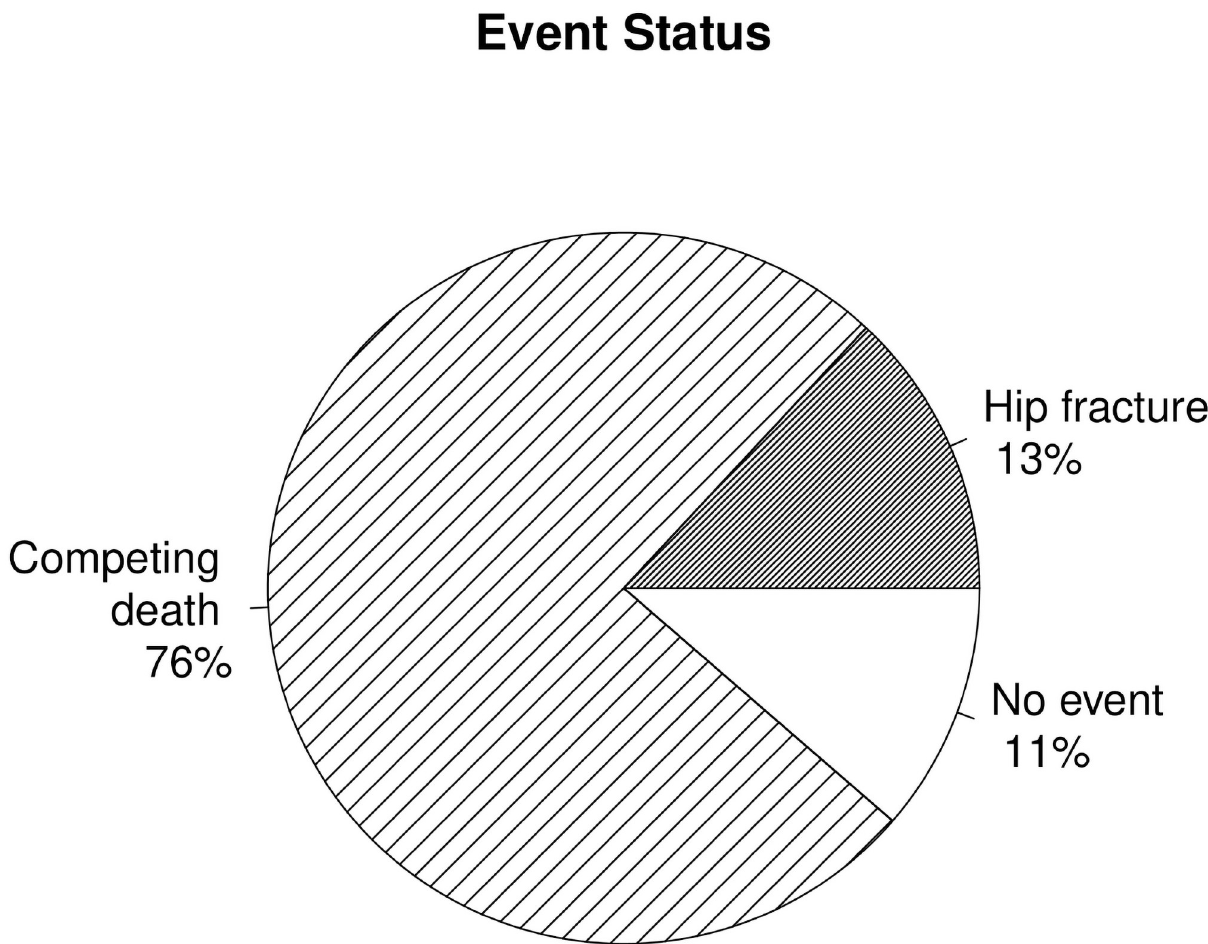
Fig 1. Events status. The 1992/93 CHS population status at the end of follow-up for incident hip fracture on June 30, 2014. 76% of the study participants suffered from the competing event of death.